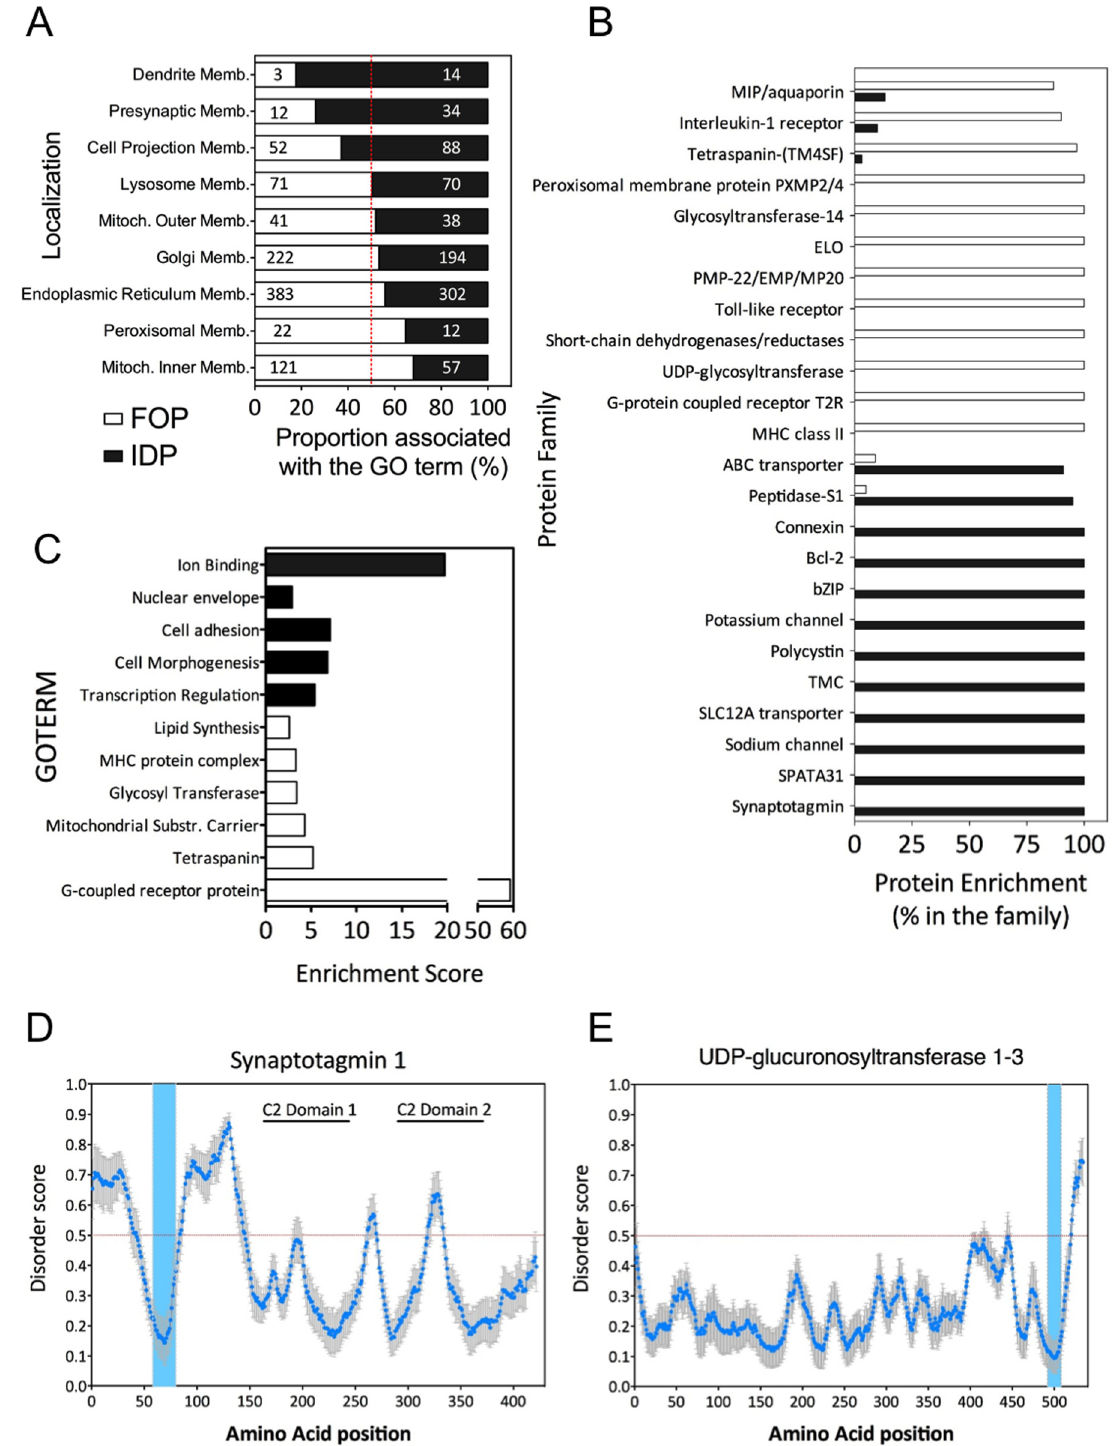
Fig 6. Cellular localizations and functions of IDPs. (A) Cellular localizations of fully folded proteins and IDPs according to their UniProt annotations. The bar graph represent the percentage of fully folded proteins or IDPs associated with a particular GOTERM compared to the total number of proteins from our dataset associated with this GOTERM. The number within the bars show the number of proteins annotated with the GOTERM (B) Protein families enriched in fully folded proteins or IDPs. The enrichment is calculated with the number of proteins in the ordered or disordered dataset compared to the total amount of